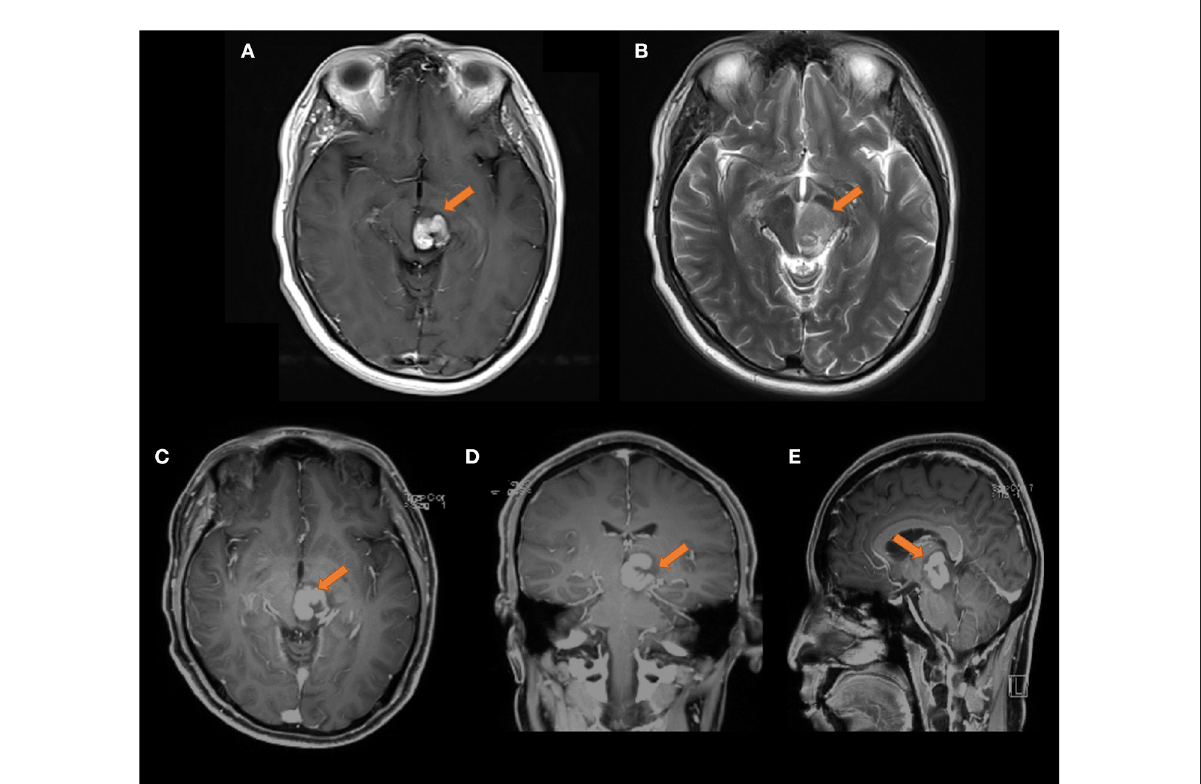
FIGURE3 Head MRI on 2019-10-08, compared with the front film (2019-09-03). (A) T1 transverse view: patchy medium high signal mass can be seen in the left thalamus and pons, the range is larger than the front, and the edge is not clear. (B) T2 transverse section: the lesions show moderate and slightly high signal. (C–E) Transverse coronal sagittal enhancement: the degree of enhancement of the lesion is higher than that of the previous film, and the lesion area is larger than the previous film, with obvious space occupying effect The size of the lesion was about 23 × 21 × 30mm.